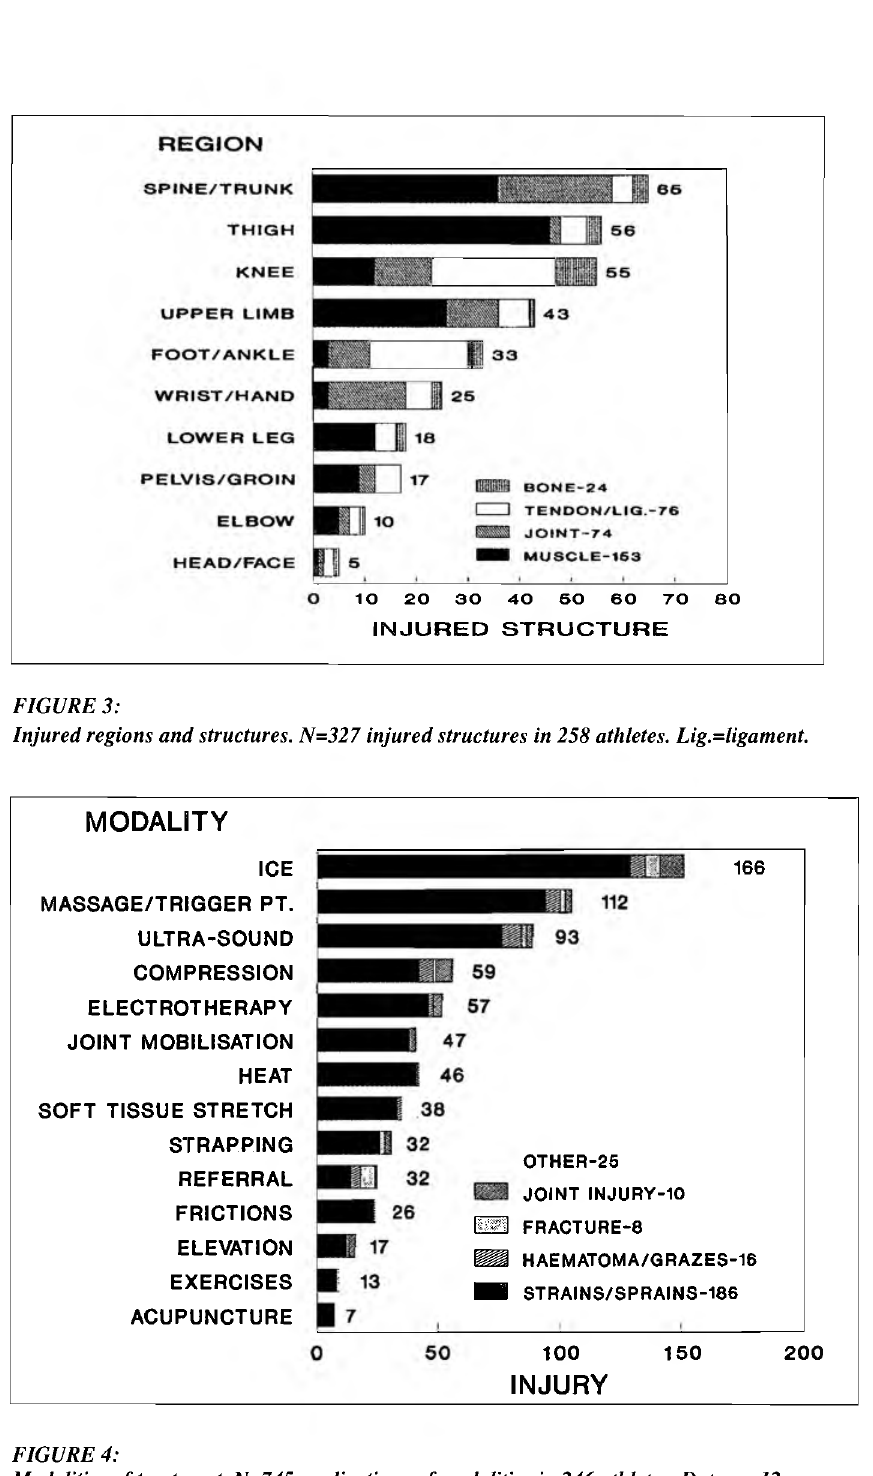
FIGURE 4: Modalities of treatment. N=745 applications of modalities in 246 athletes. Data on 12 cases were missing. Joint injury included dislocation, subluxation and effusion. Others included cramp, nerve compression, vascular damage, retropatellar pain and “shin